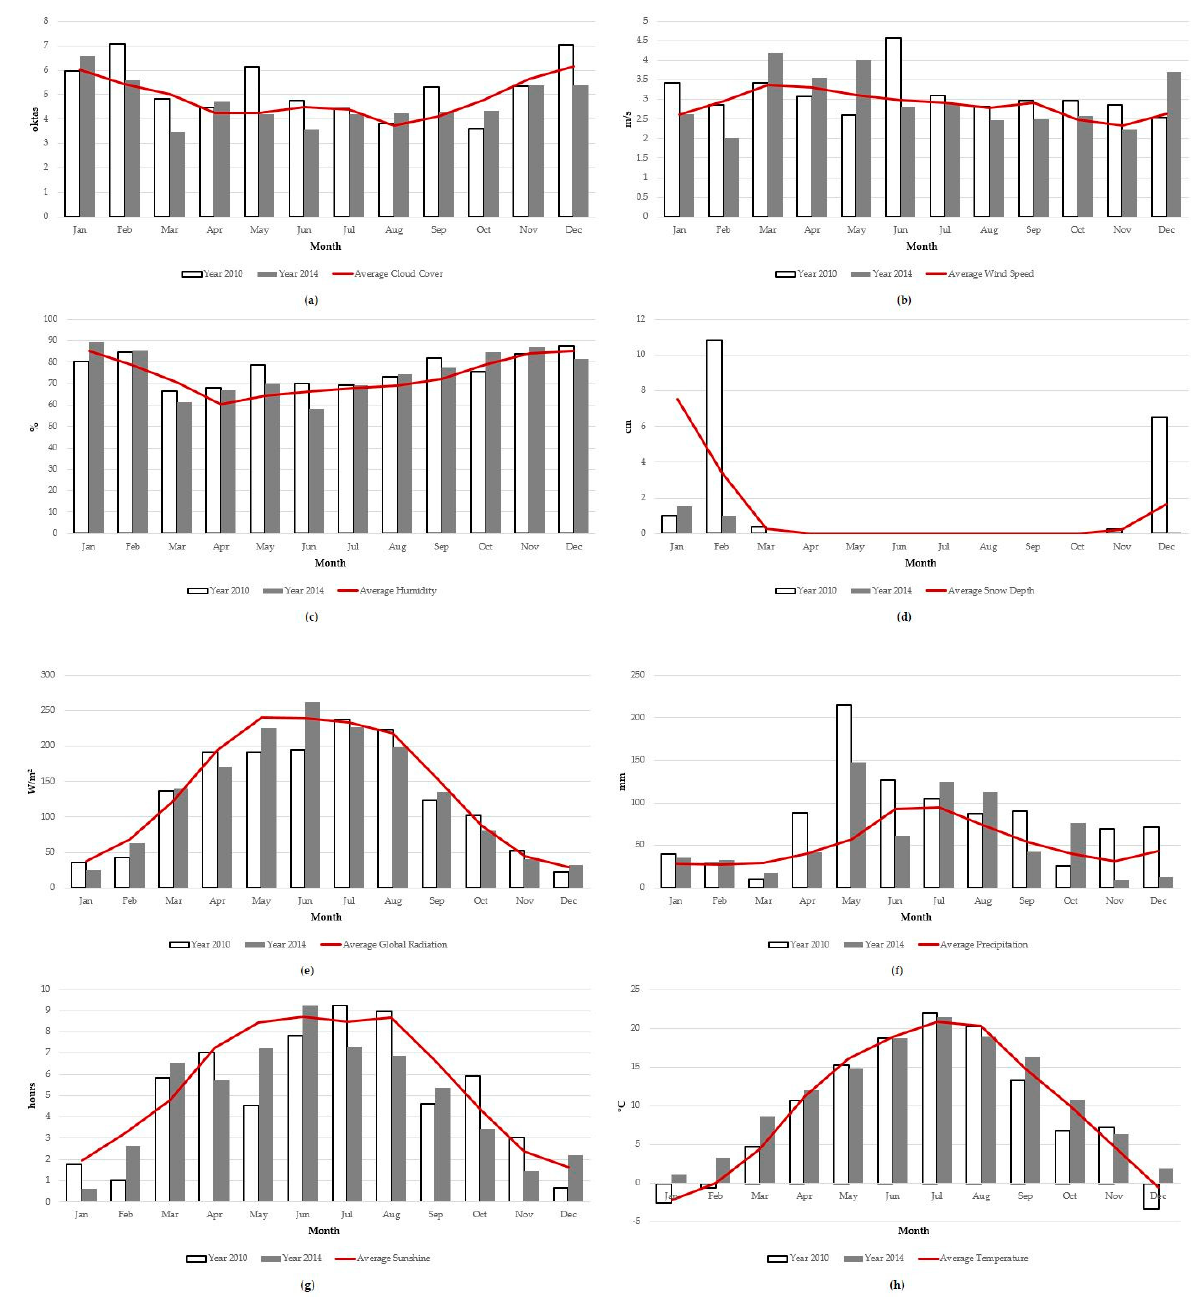
Figure 8. Monitored meteorological parameters for the years 2010 and 2014: ( a ) cloud cover (oktas); ( b ) wind speed (m/s); ( c ) humidity (%); ( d ) snow depth (cm); ( e ) global radiation (W/m 2 ); ( f ) monthly precipitation (mm); ( g ) average daily sunshine (hours); ( h ) mean temperature ( ◦ C). Source: http://www.ecad.eu (accessed on 17 July).